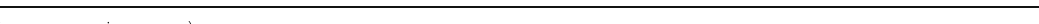
(See figure on previous page.) Fig. 3 EA restrained insulin resistance in PCOS-like rats via enhancing autophagy. a The serum insulin level was detected by a commercial ELISA kit. b The HOMA-IR index was detected and shown. c-f The protein levels of GLUT4, p-AKT, AKT, p-ERK, and ERK in skeletal muscle tissues were determined by Western blotting. g Expression of GLUT4 in plasma membrane of skeletal muscle tissues was detected by Western blotting. The experimental data are presented as mean ± standard deviation (n = 6). * P < 0.05, ** P < 0.01, *** P < 0.001, vs the indicated group. PCOS,